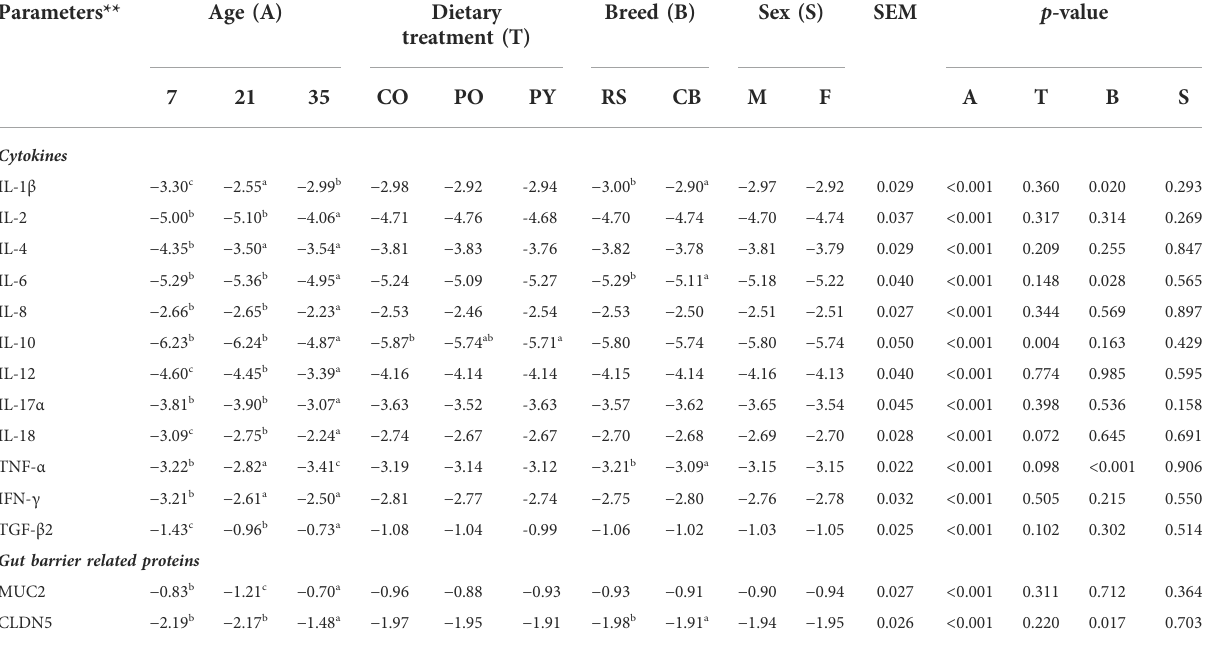
TABLE 5 The impact of age, dietary treatment, sex and breed on expression of the genes (log 10 copy number per ng of RNA a ) related to epithelial barrier function and in fl ammatory markers of the caecum*